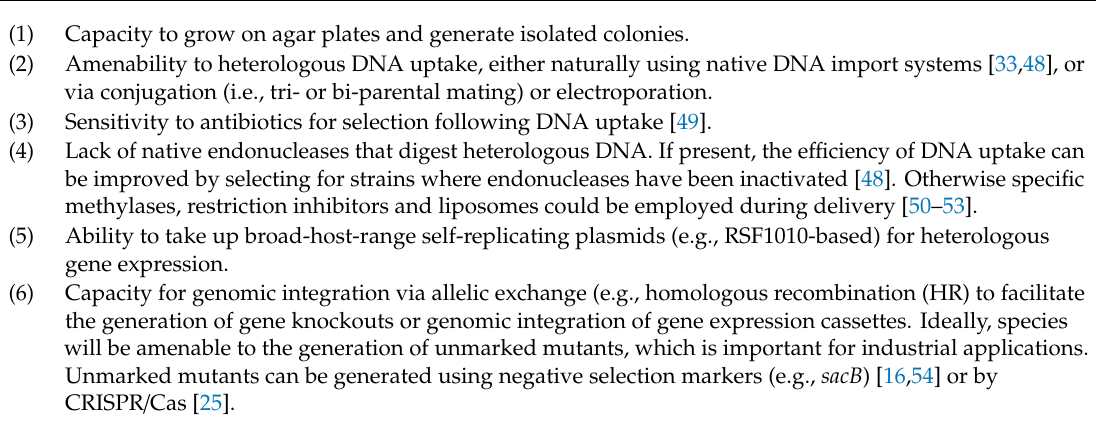
Table 1. Desirable features required for culturing and genetically engineering cyanobacterial